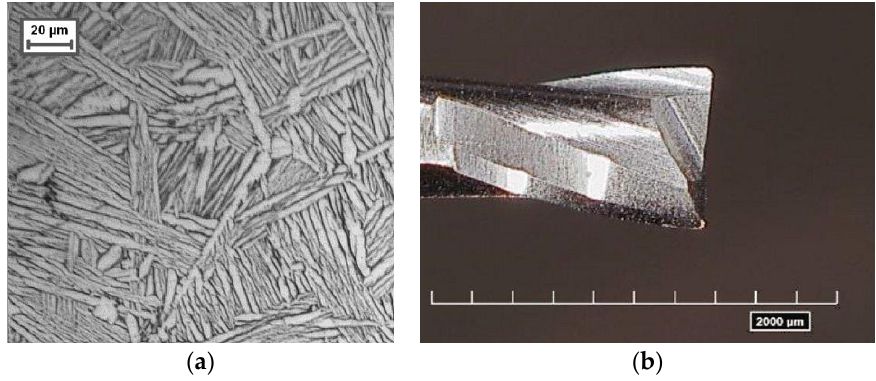
Figure 8. ( a ) Widmanstätten microstructure of Ti6Al4V sample; ( b ) Micro end mill (SECO-JM905L008-MEGA-T). Table 1. Chemical composition of Ti6Al4V (percentage in weight).